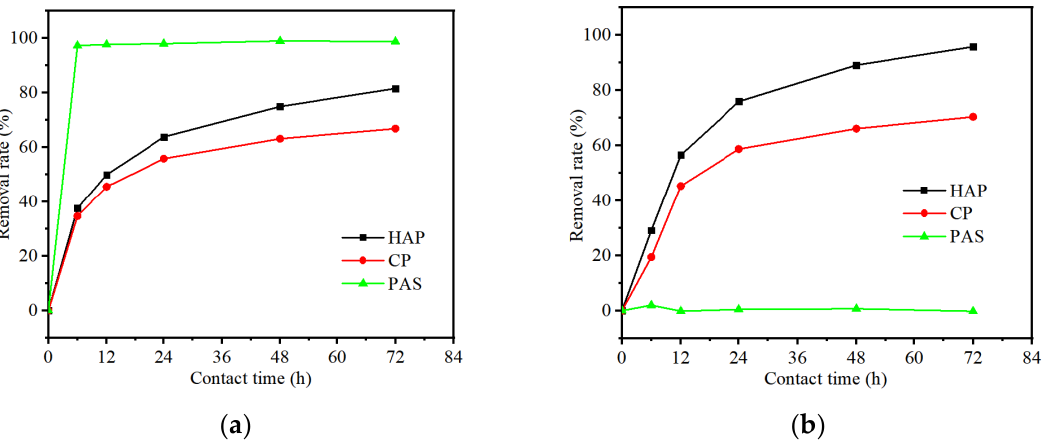
Figure 2. The removal performances of HMs on three phosphates (HAP, CP, PAS) in aqueous solution, ( a ) Cu 2+ removal, and ( b ) Zn 2+